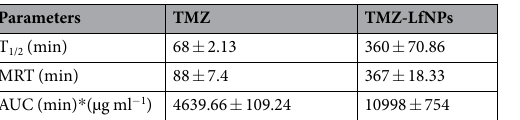
Table 1. Comparative plasma pharmacokinetic parameters after i.v. injection of free TMZ and TMZ-LfNPs with an equivalent TMZ dose of 10 mg kg − 1 in mice (n = 3). T 1/2 - elimination half-life of drug, MRT- mean residence time of drug in the plasma, AUC-The area under